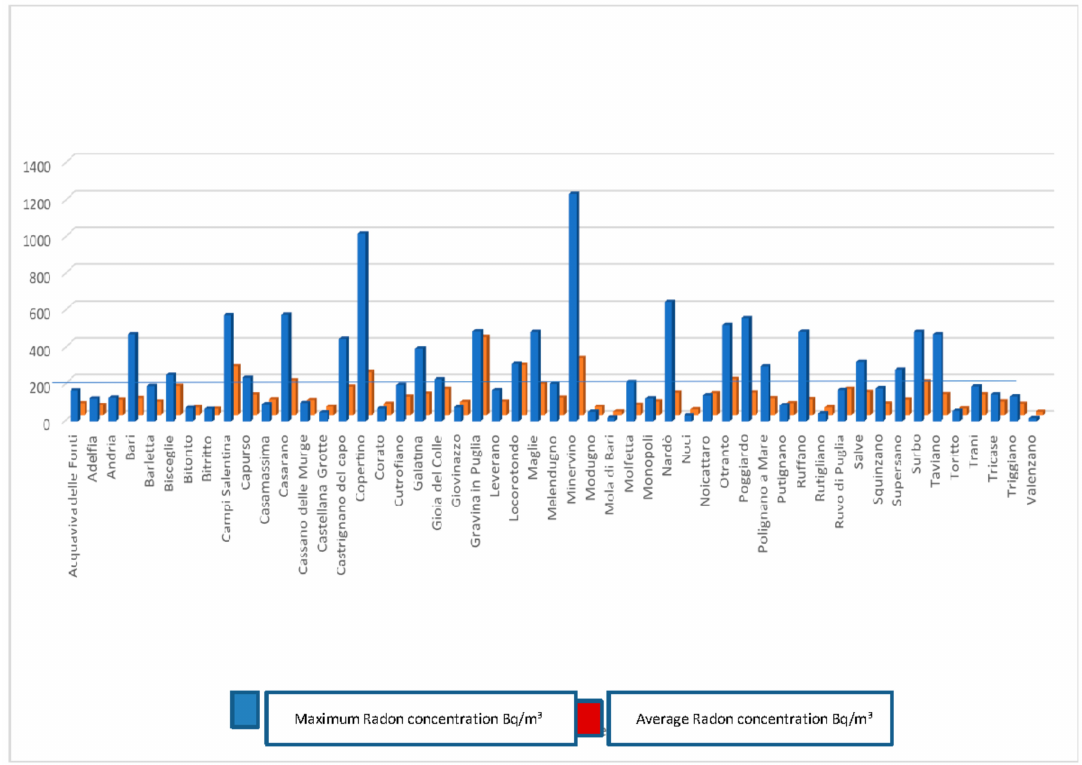
Figure 3. Radon concentrations in the 51 studied